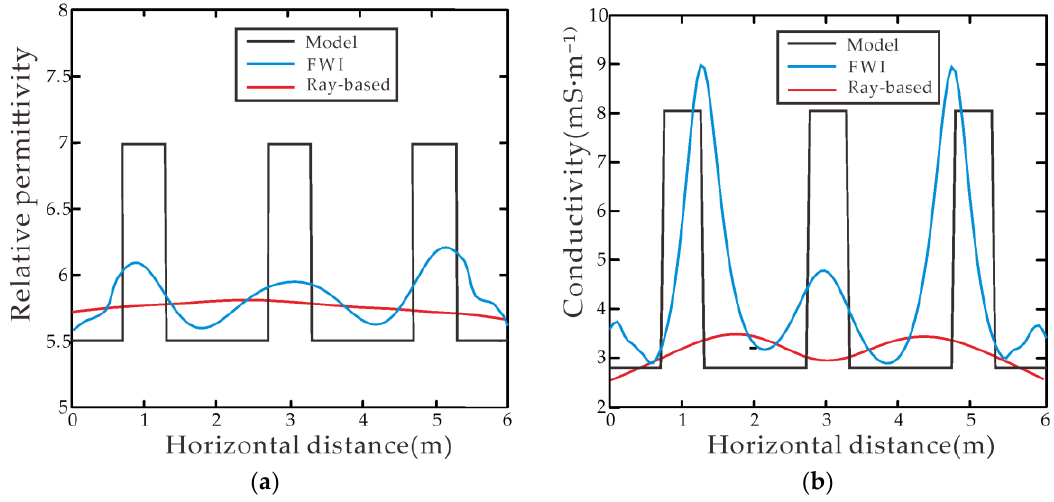
Figure 6. Comparisons among the inverted results from FWI, ray-based, and the true model at the depth of 3 m: ( a ) relative permittivity and ( b ) conductivity.